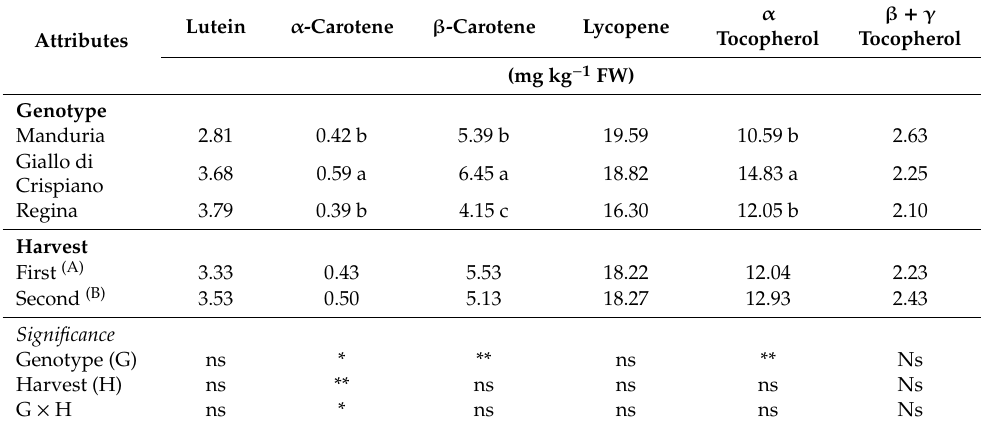
Table 5. Main effects of genotype and harvest time on carotenoids and tocopherols of tomato fruits.